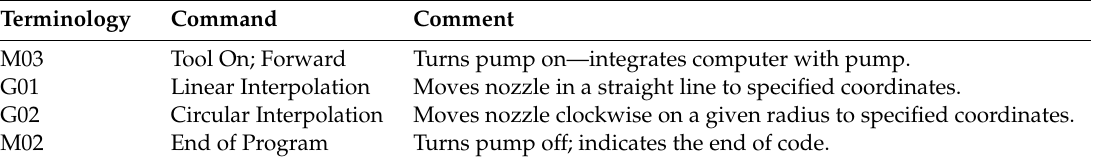
Table 1. Sample of Commonly Used G-Code